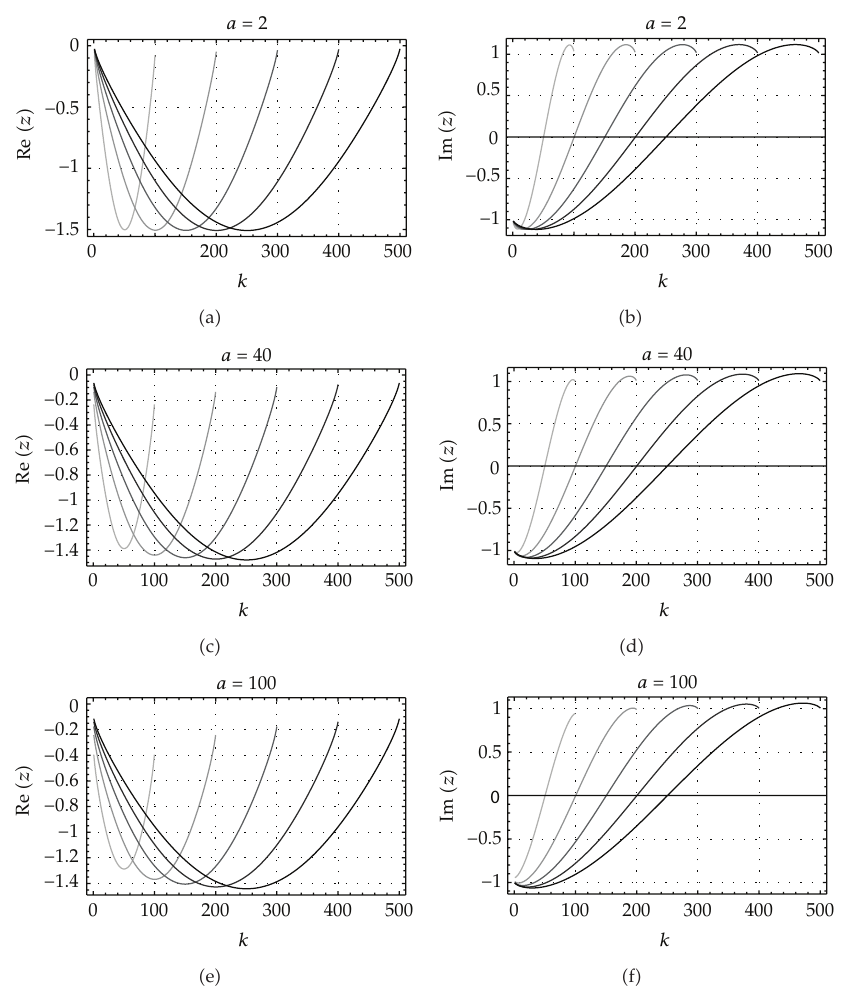
Figure 1: Real and imaginary parts of the zeros of the normalized Bessel polynomials y n (cid:2) 2 z/ (cid:2) 2 n (cid:5) a − 2 (cid:3) ; a (cid:3) for a (cid:4) 2 , 40 , 100. They are plotted as functions of k for n (cid:4) 100 , 200 , 300 , 400 , 500, in gray-level intensity, from lower to higher, according to the value of n